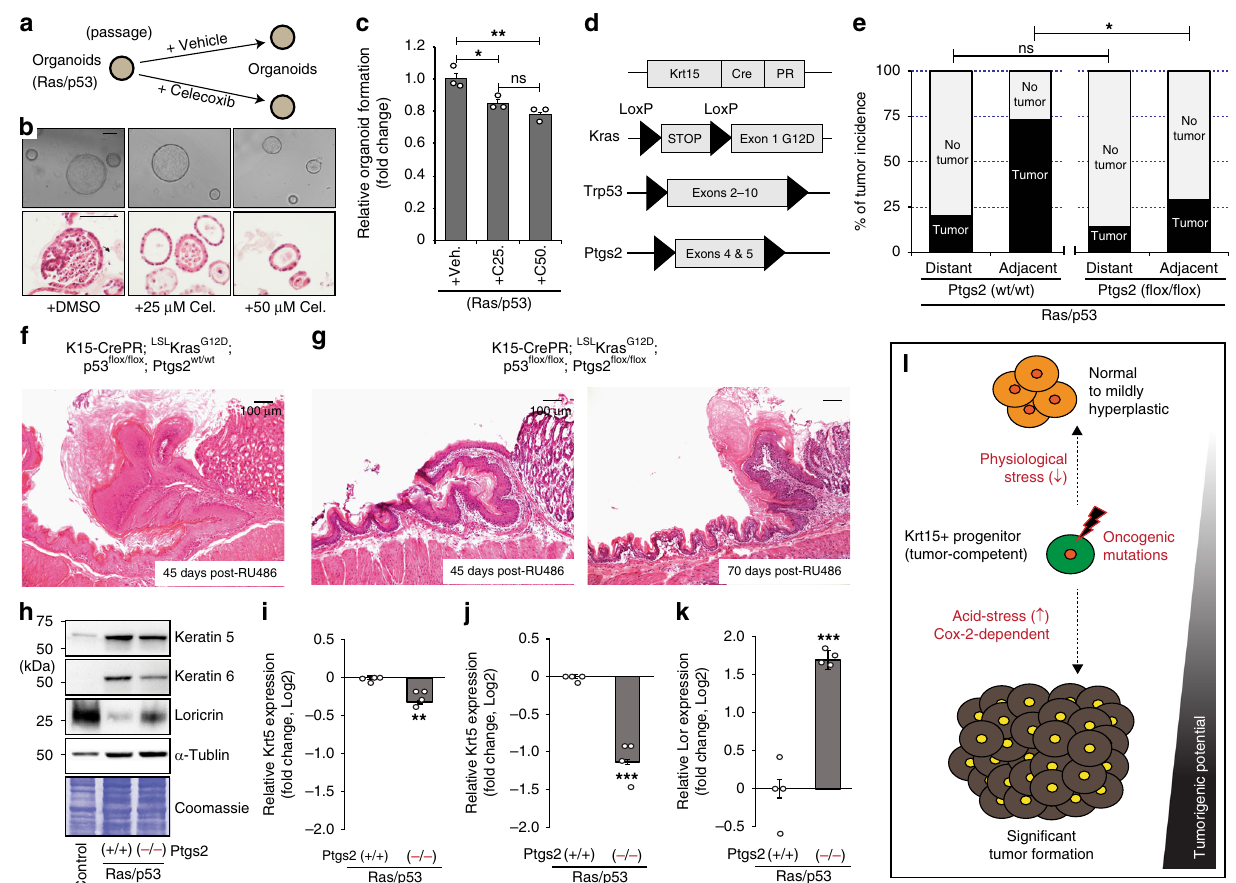
Fig. 5 Role of cell-type-speci fi c cyclooxygenase-2 (Cox-2) expression in Ras/p53-mediated tumor formation. a Experimental scheme. b Microscopic phenotype and histology of three-dimensional (3D) organoids with/without celecoxib treatment. c Relative 3D organoid formation was determined by the number of organoids larger than 100 µ m, n = 3 independent experiments, 25 fi elds at high power fi eld (HPF) per sample. Veh, vehicle control; C25, 25 µ M; C50, 50 µ M celecoxib. d Experimental scheme. e Ras/p53-mediated tumor incidence with/without condition Cox-2 knockout. Ptgs2 wt/wt , n = 15 animals; Ptgs2 fl ox/ fl ox , n = 14 animals. f , g Histological phenotypes. h – k Immunoblotting of Keratin5 (Krt5), Krt6 and Loricrin (Lor) demonstrated decreased